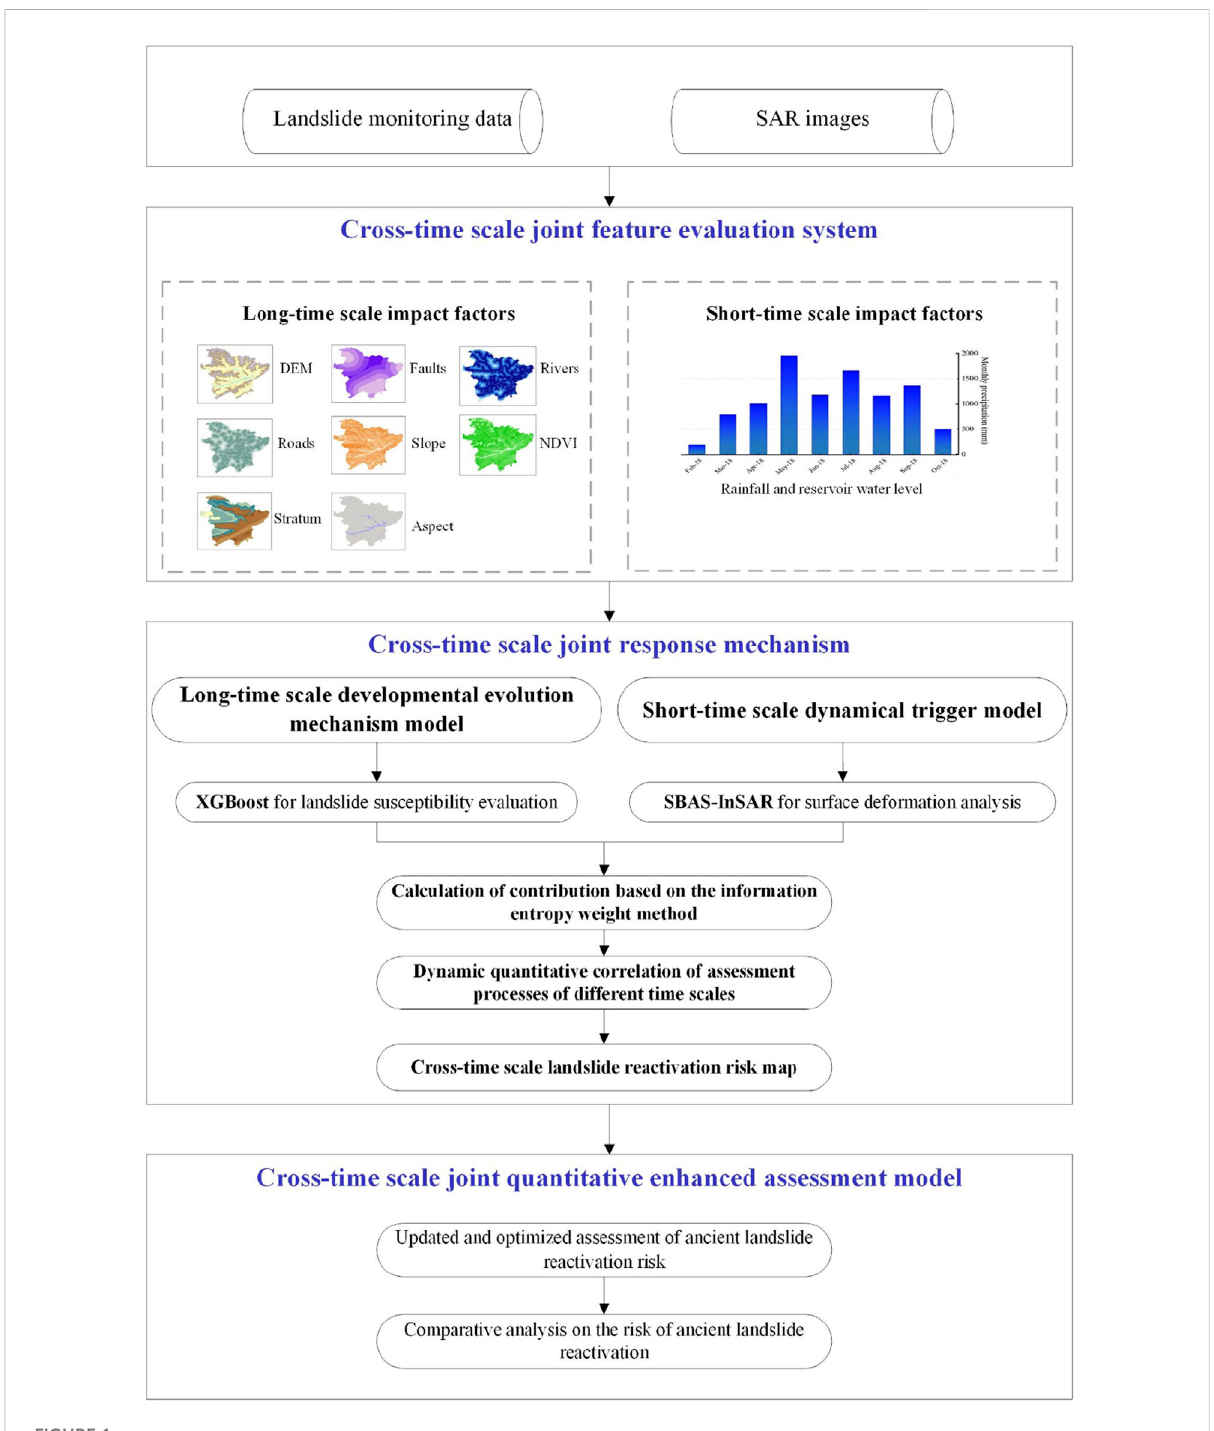
FIGURE 1 Overall fl owchart of the cross-time scale joint quantitative enhanced assessment